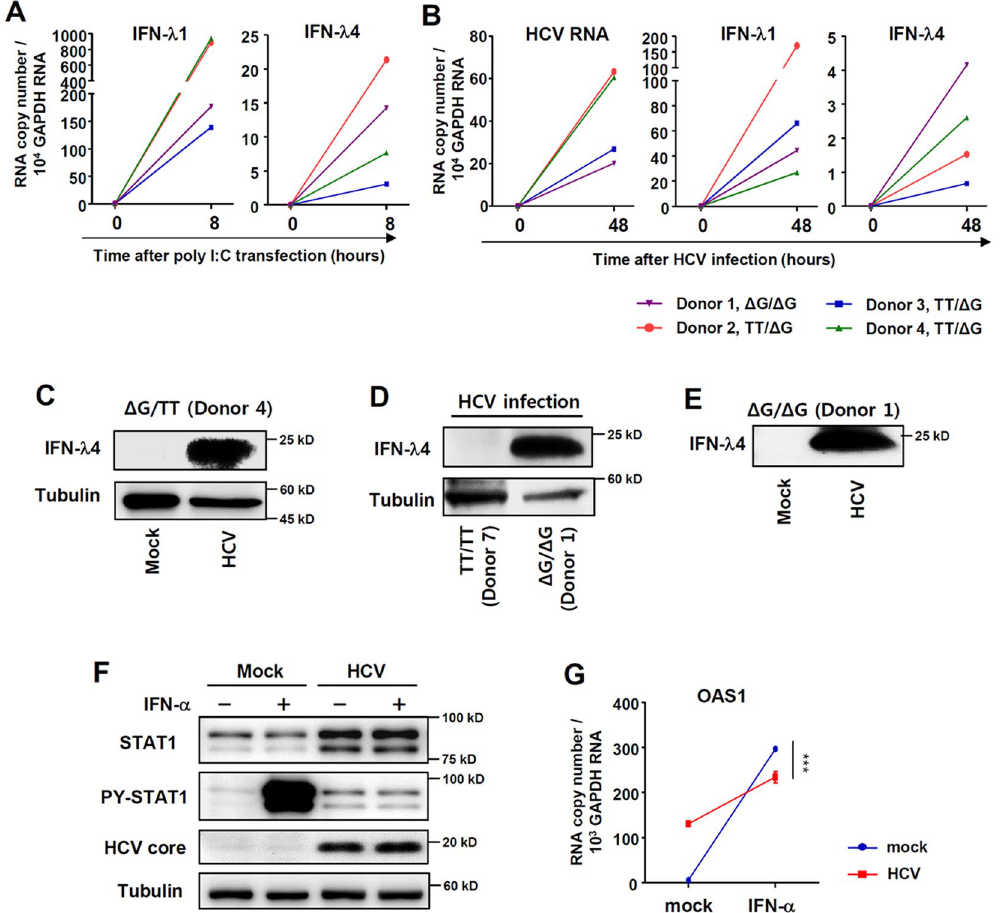
Figure 1. HCV infection results in IFN- λ 4 expression and IFN- α unresponsiveness. ( A ) PHHs from 4 different donors were transfected with poly(I:C) (6 µ g/ml). After 8 hours, the cells were harvested, and gene expression was analysed by real-time qPCR. ( B ) PHHs from 4 different donors were infected with JFH1 HCVcc at 10 MOI. After 48 hours, the cells were harvested, and gene expression was analysed by real-time qPCR. ( C ) PHHs with IFNL4 Δ G/TT genotype were infected with JFH1 HCVcc at 10 MOI. After 72 hours, the cell lysate was harvested, and protein expression were analysed by immunoblotting. ( D ) PHHs from two different donors (one with IFNL4 TT/TT genotype and the other with IFNL4 Δ G/ Δ G genotype) were infected with JFH1 HCVcc at 10 MOI. After 72 hours, the cell lysates were harvested, and protein expression were analysed by immunoblotting. ( E ) PHHs with IFNL4 Δ G/TT genotype were infected with JFH1 HCVcc at 10 MOI. After 72 hours, the culture supernatant was harvested, and IFN- λ 4 protein expression was analysed by immunoblotting. The data are representative of two independent experiments. ( F , G ) PHHs with the IFNL4 Δ G/ Δ G genotype were infected with JFH1 HCVcc at 5 MOI. After 72 hours, the cells were treated with 100 IU/ ml IFN- α for 30 minutes ( F ) or 6 hours ( G ). The cells were harvested, and gene and protein expression were analysed by immunoblotting ( F ) or real-time qPCR ( G ). Data are presented as means ± S.E.M. *** P ≤ 0.001 (Student’s t-test). All the data are representative of two independent experiments. Full-length blots of PY-STAT1 ( F ) with multiple exposure times are included in the Supplementary Fig.